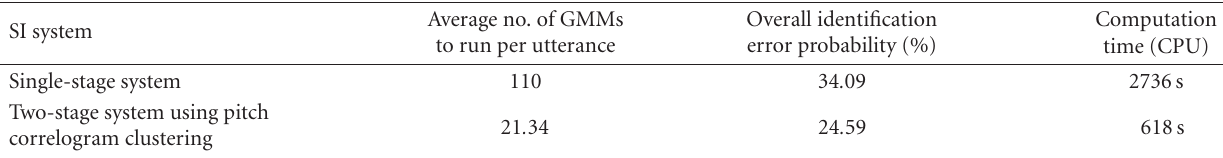
Table 3: Comparison of SI systems with and without